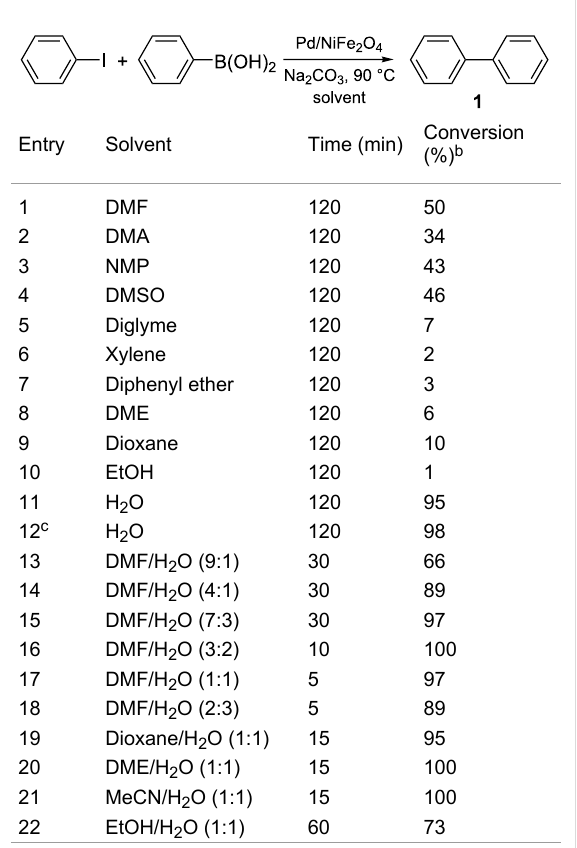
Table 1: The effect of different solvents on the Suzuki coupling reac- tion a